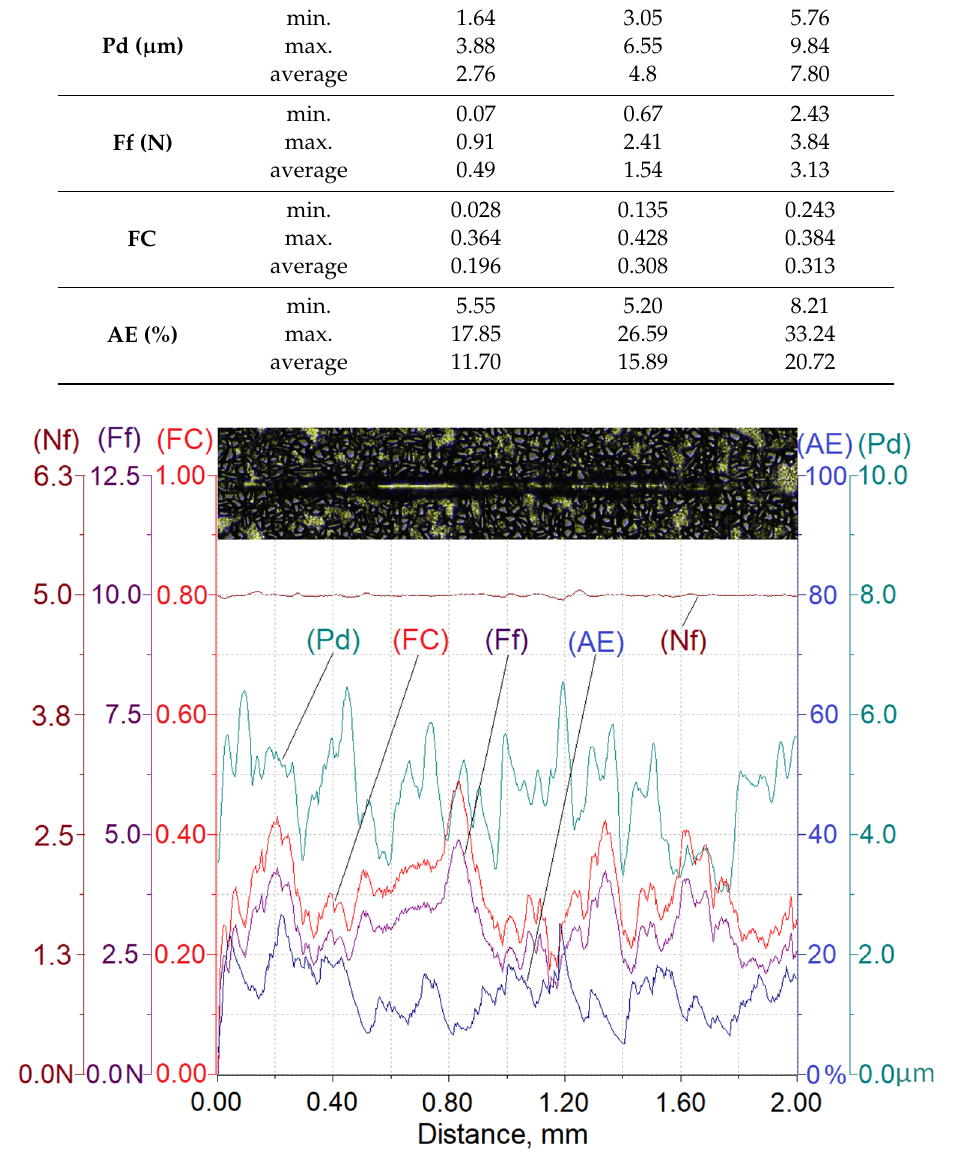
Figure 9. Results of AlSi12 / SiC p composite layer scratch testing for the normal load force Nf = 5 N; Nf—normal force, Pd—penetration depth, Ff—frictional force, FC—friction coefficient, AE—acoustic emission.